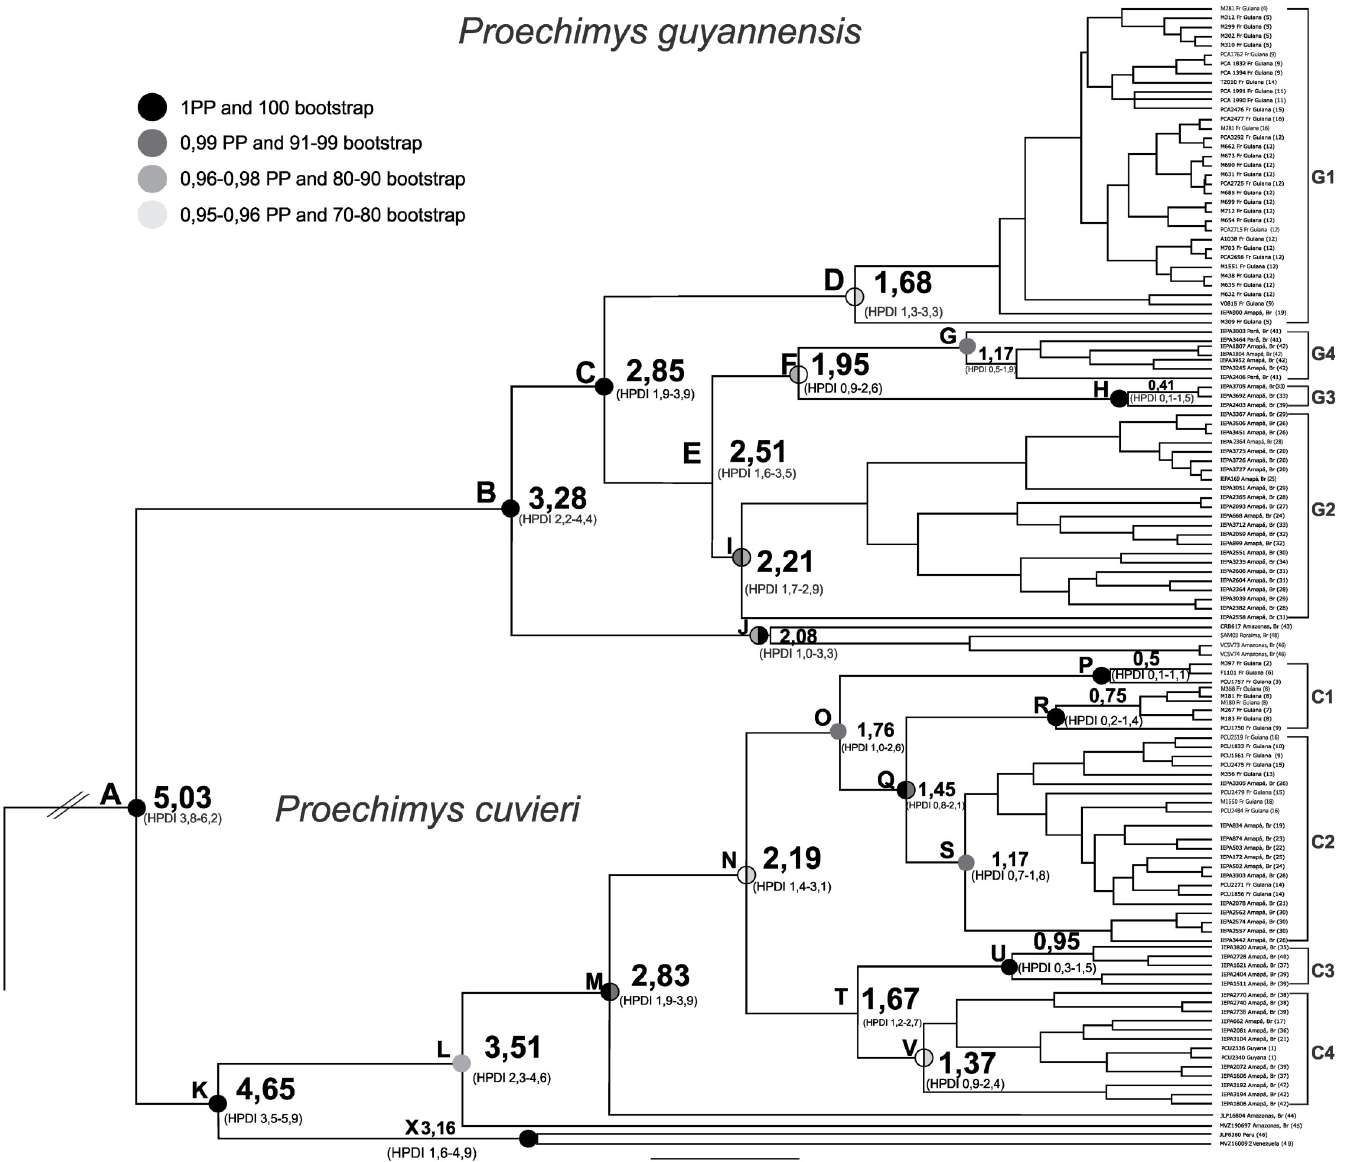
Fig 2. Molecular dating chronogram using cytochrome b with a HKY + I + G model (ML and BI topology presents similar topology). Statistical support higher than 0.90 posterior probability (PP) and 70 bootstraps is identified next to the nodes divided in two sides, the left side represents PP values and the right side the bootstrap values; black represent 1 PP and 100 bootstrap, very dark gray represent 0,99 PP and 91–99 bootstrap, dark gray represent values between 0.96–0.98 PP and 80–90 bootstrap, and light gray represents values between 0.95–0.96 PP and 70–80 bootstrap. The letters B, C, D, E, F, G, H, J and I identify clades formed in P . guyannensis . The letters K, L, M, N, O, P, Q, R, S, T, U, V and X identify clades formed in P . cuvieri . Each terminal is identified for sample followed by country of origin. The numbers in the parentheses identified the locality in the Fig 1. We also identified the state of origin in the case of Brazil. Clusters recovered by BAPS are identified after the terminals for P . guyannensis (G1, G2, G3, G4) and for P . cuvieri (C1, C2, C3, C4). Inferred spliting dates are shown on the